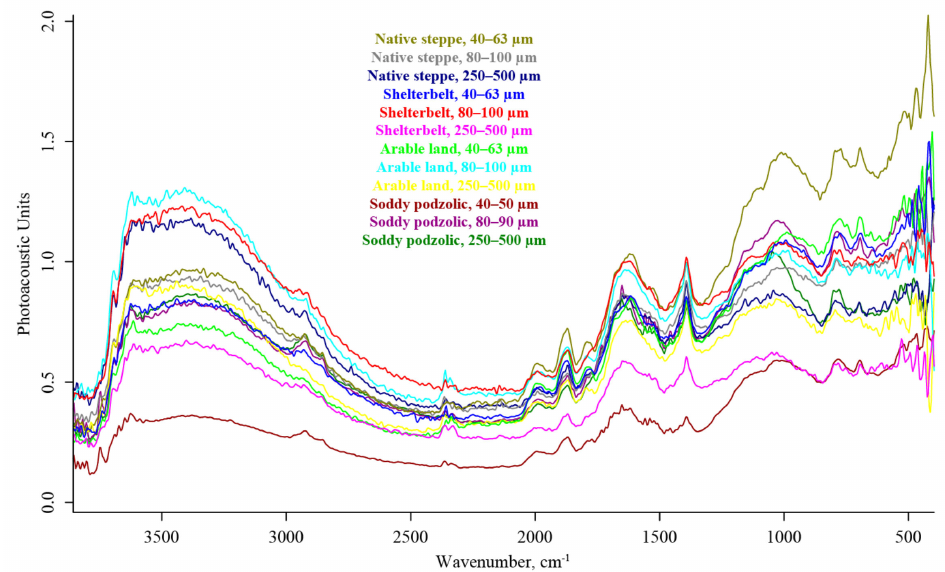
Figure 3. FTIR–PAS spectra (IMF, 1.6 kHz) of fractions of chernozem and sod-podzolic soils. Cher- nozem native steppe, 40–63 µ m, khaki; 80–100 µ m, gray; 250–500 µ m, dark blue; chernozem shelter- belt, 40–63 µ m, blue; 80–100 µ m, red; 250–500 µ m, light magenta; chernozem arable land, 40–63 µ m, light green; 80–100 µ m, light blue; 250–500 µ m, yellow; sod-podzolic, 40–50 µ m, dark red; 80–90 µ m, dark magenta; 250–500 µ m, dark